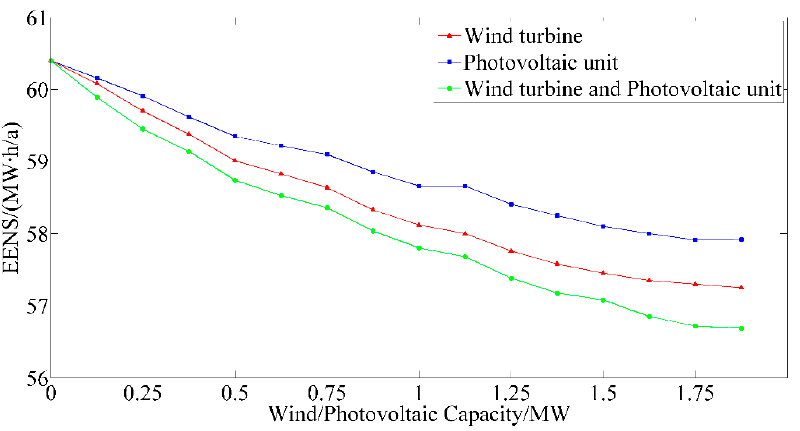
Figure 7. EENS with different WT and PV capacities.